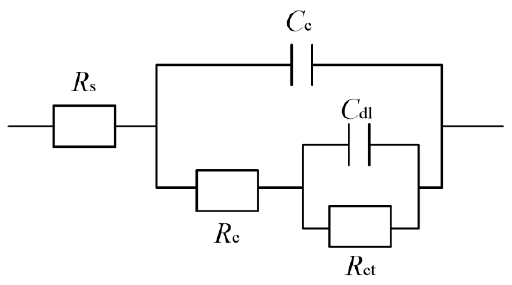
Figure 25. Samples equivalent circuit model in artificial seawater. Table 7. Analyzing results of potentiodynamic polarization curves of samples.